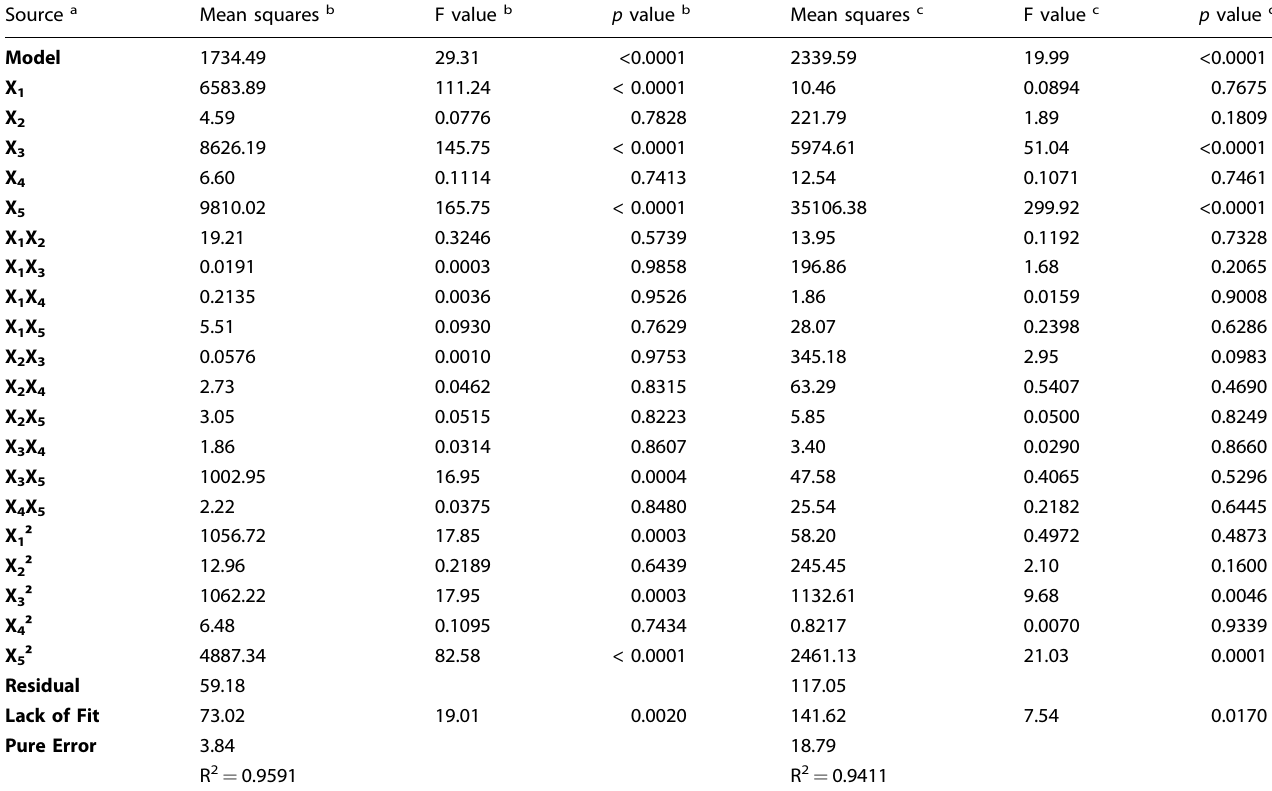
Table 1. Analysis of variance (ANOVA) of the response surface quadratic